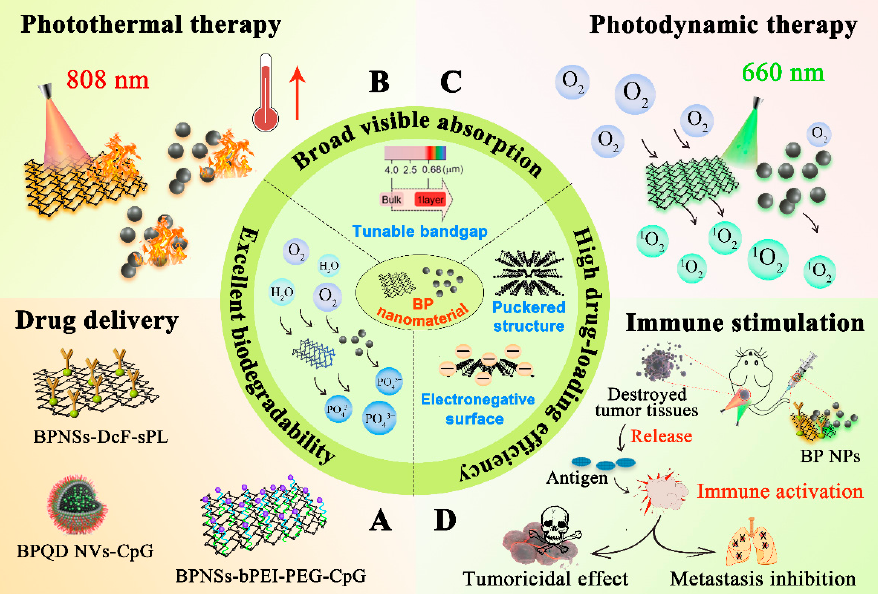
Figure 1. Schematic illustration of the outstanding properties of BP nanomaterials and their